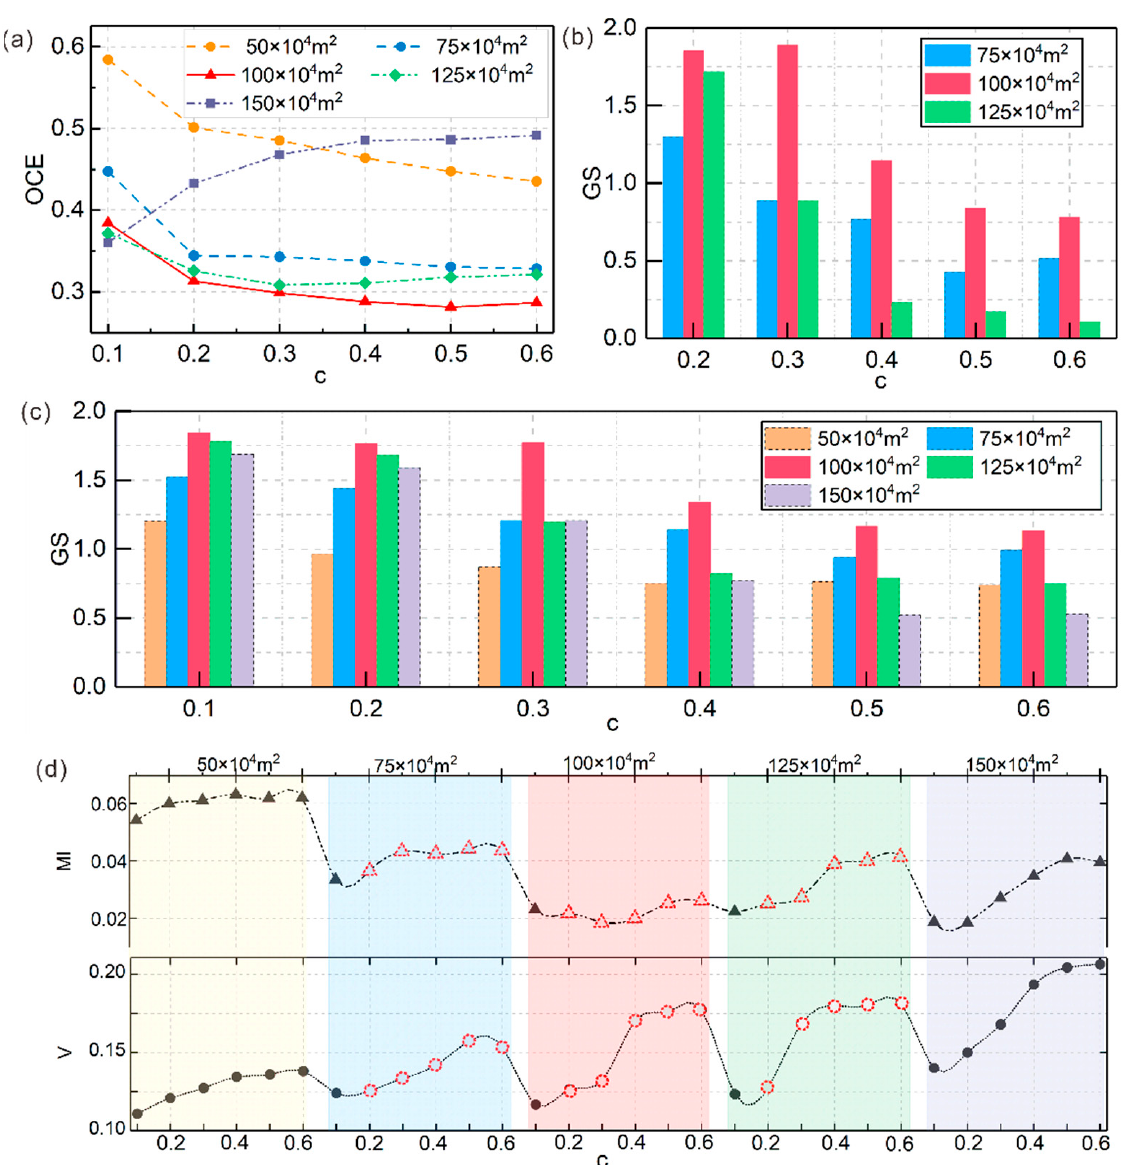
Figure 6. The global function values of SUs. ( a ) is the OCE , ( b ) is GS for the remaining 15 SUs with OCE under 0.35. ( c , d ) are the GS and global MI , global V of 30 SUs, respectively. The red dotted icons in ( d ) indicate the MI and V involved in the calculation of GS of ( b ).